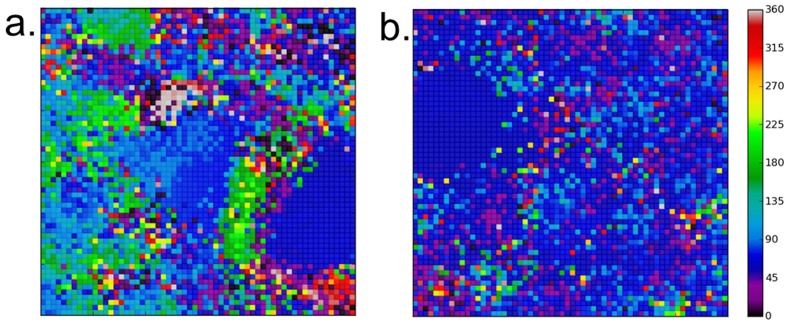
Direction Preference maps for reduced lateral inhibition.In both cases reducing lateral inhibition has almost completely disrupted the characteristic patchy structure seen in previous figures. When a 5×5 connection field is present (a) there are some patches of the same preference and topological arrangement of patches of similar preference but nowhere near as structured as the intact case. With full afferent connectivity (b) there is complete map disruption: most neurons are active for all of the motion directions and selectivity is very low (see Table 5).